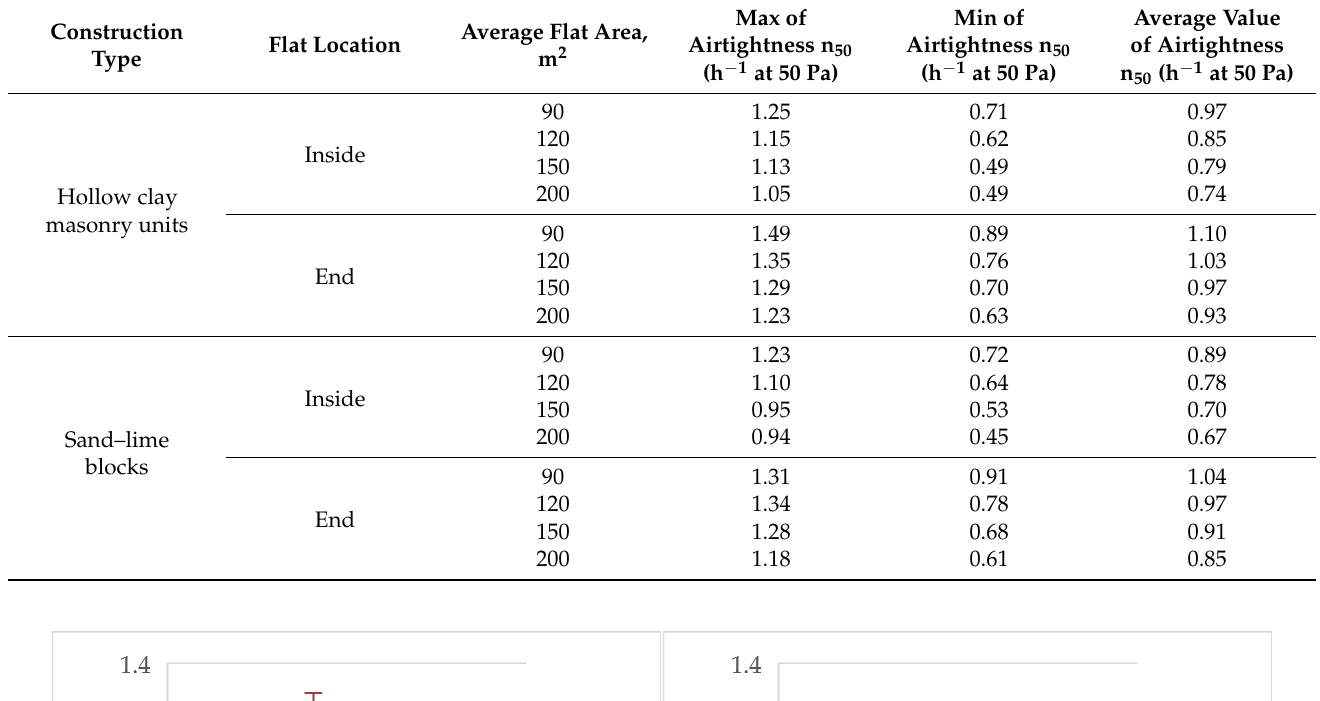
Table 2. Measurement values of the airtightness of the flats.